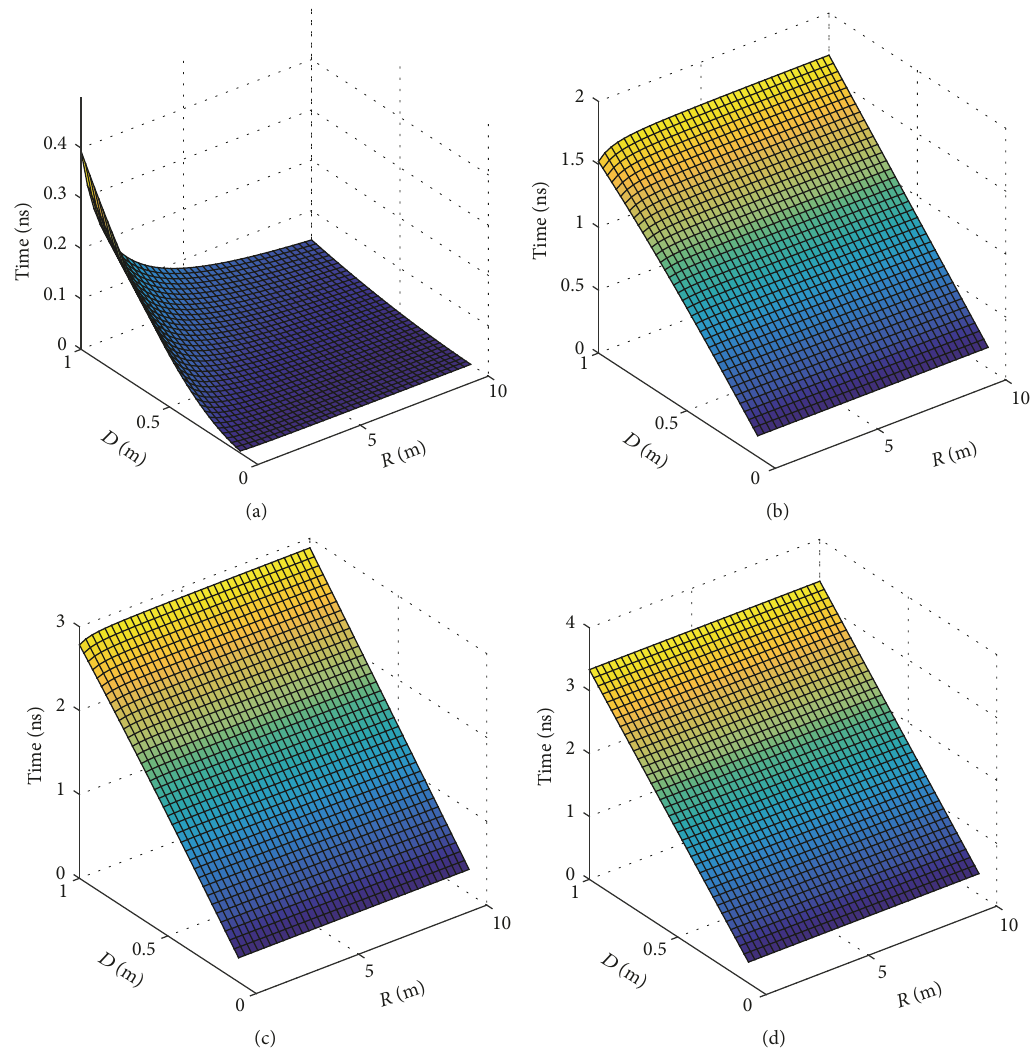
Figure 8: Time delay for antenna separation distance versus receive antenna diameter: (a) 𝜃 = 0 ∘ , (b) 𝜃 = 30 ∘ , (c) 𝜃 = 60 ∘ , and (c) 𝜃 = 90 ∘